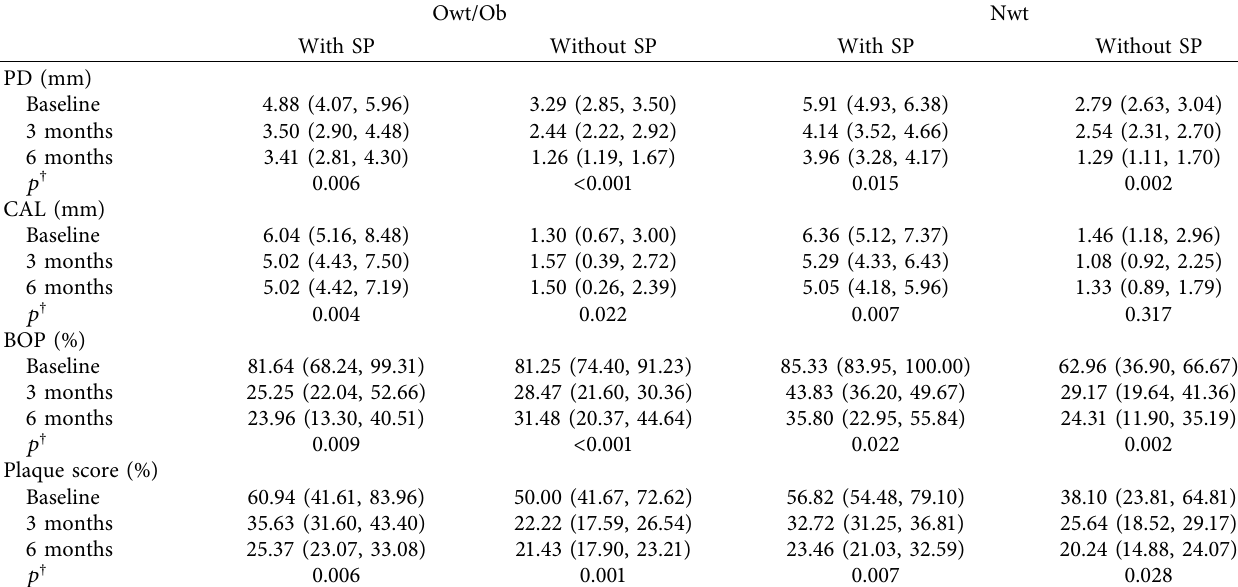
Table 2: Periodontal parameters at baseline, as well as at 3 and 6 months after periodontal treatment, according to BMI and periodontal disease status.